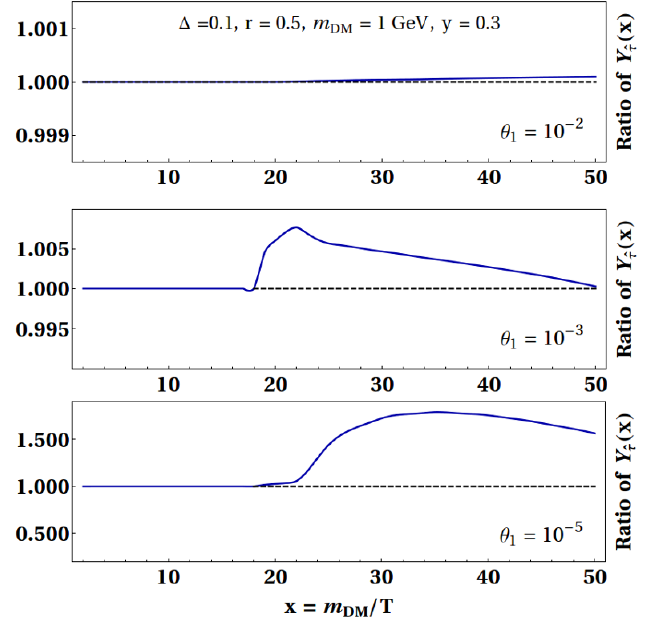
Figure 9 . The ratios of Y ^ (cid:28) from the (cid:12)rst iteration and the initial input from the coannihilation calculation for 3 benchmarks di(cid:11)er by the mixing angle (cid:18) 1 described in the text. The top plot corresponds to a coannihilation phase, where ^ (cid:23) and ^ (cid:28) are in approximate chemical equilibrium during the freeze-out. The bottom plot corresponds to a coscattering phase, where ^ (cid:28) only deviates from the initial guess after S has already decoupled, thus it is unable to a(cid:11)ect S freeze-out. The middle plot represents a mixed phase. In this case, the maximal deviation happens simultaneously as S decouples, resulting in a larger iterative correction to the DM density. However, the correction is still very